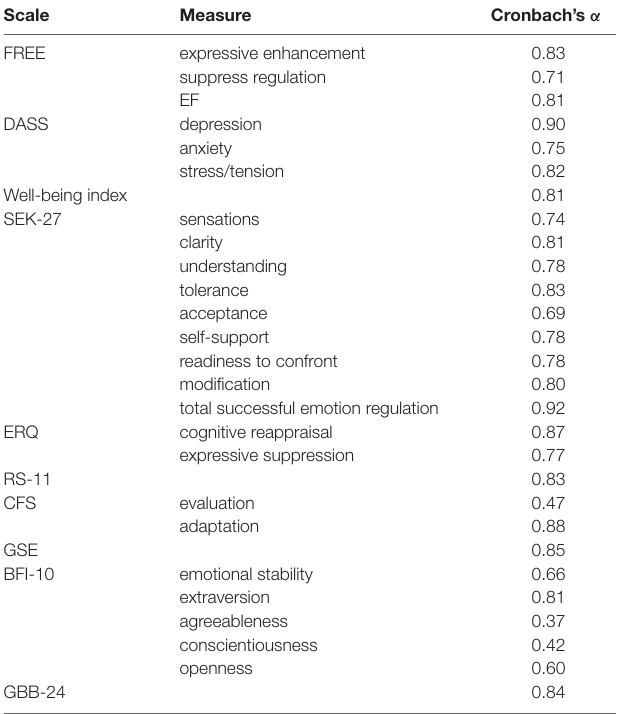
TABLE 1 | Reliability and internal